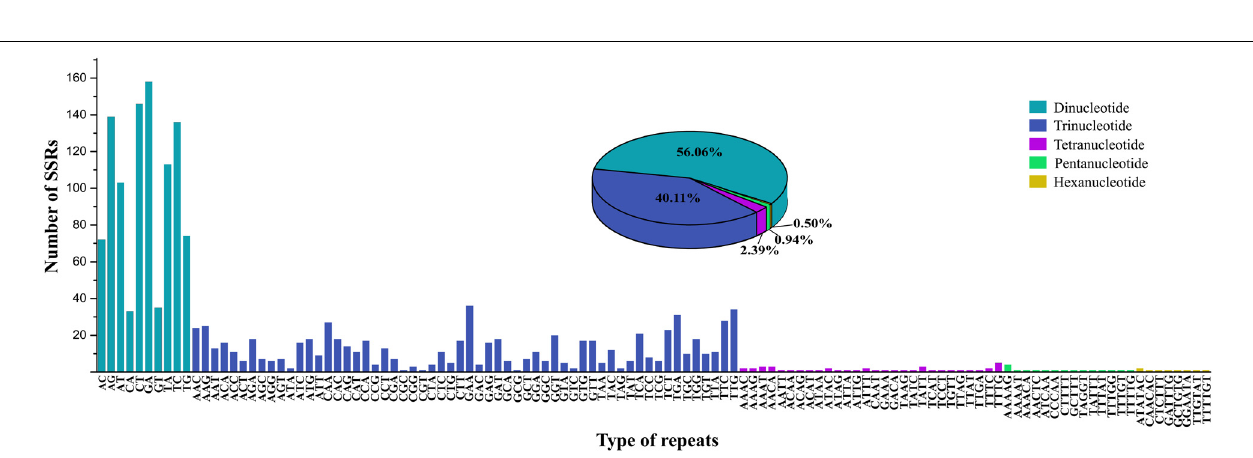
FIGURE 4 | Comparative analysis of the nucleotide variability ( π ) values within the genus Tiarella . The dotted line represents π > 0.01; genes surpassing this threshold are highlighted in gray.